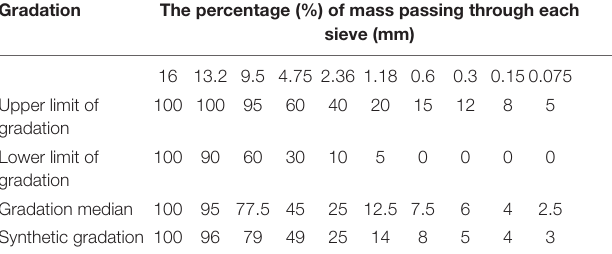
TABLE 5 | LB-13 gradation. Gradation